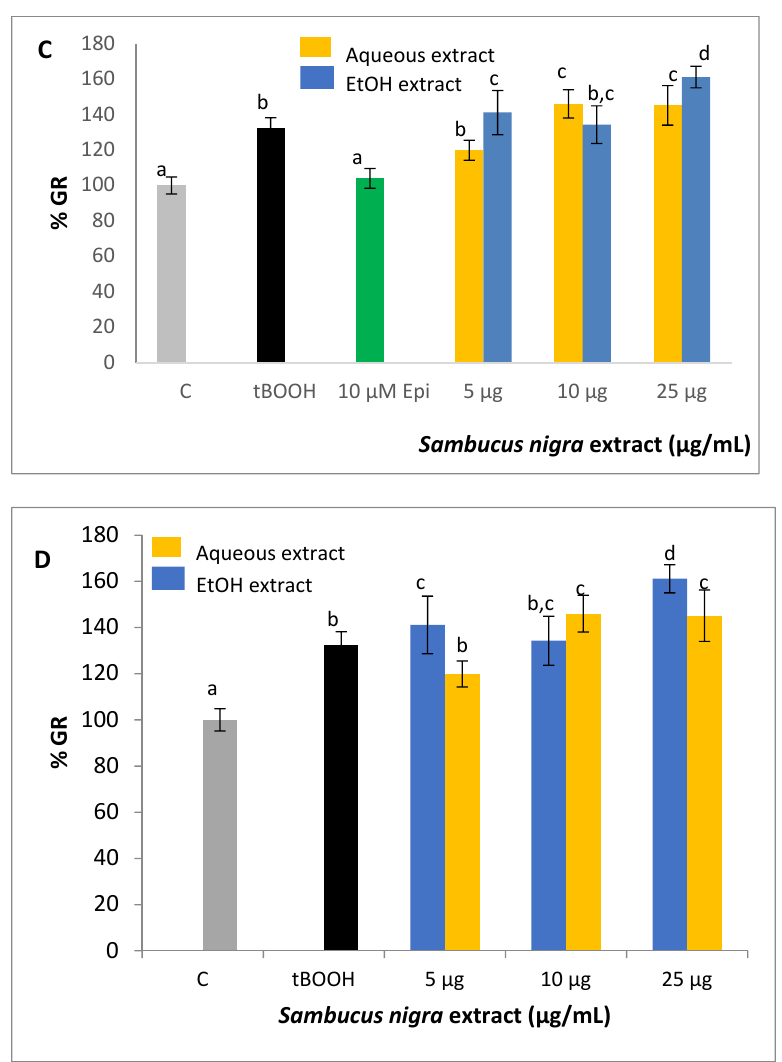
Figure 5. Protective effect of aqueous and ethanolic extracts from S. nigra flowers on the enzymatic antioxidant defenses of SH-SY5Y cells. ( A , C ) Effect of co-treatment of S. nigra extracts on GPx and GR values. ( B , D ) Effect of pre-treatment of S. nigra extracts on GPx and GR values. Values are expressed as a percent relative to activity of control condition and are means ± SD, n = 4. Different letters indicate statistically significant differences ( p < 0.05) among groups.